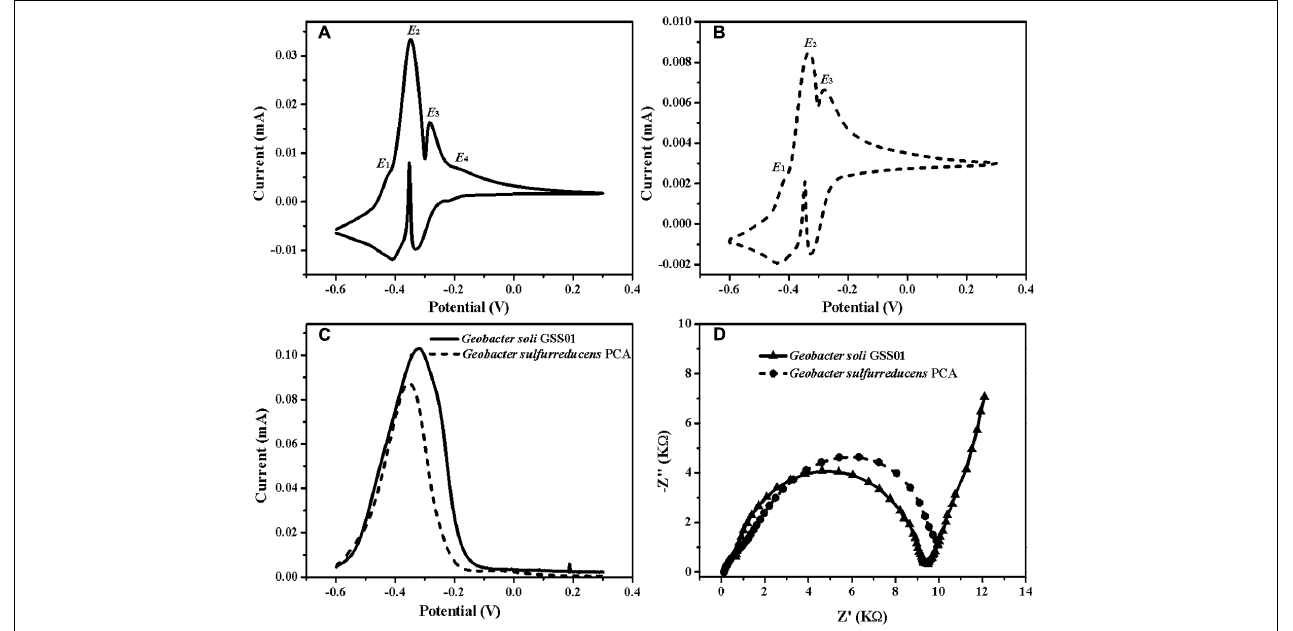
FIGURE 2 | CVs of the anode biofilms of G. soli GSS01 (A) and G. sulfurreducens PCA (B) under the non-turnover conditions (scan rate: 1 mV/s). (C) DPV of the anode biofilms of G. soli GSS01 and G. sulfurreducens PCA under turnover conditions. (D) Nyquist plots of EIS spectra for the anode biofilms of G. soli GSS01 and G. sulfurreducens PCA. Results are representative of triplicate